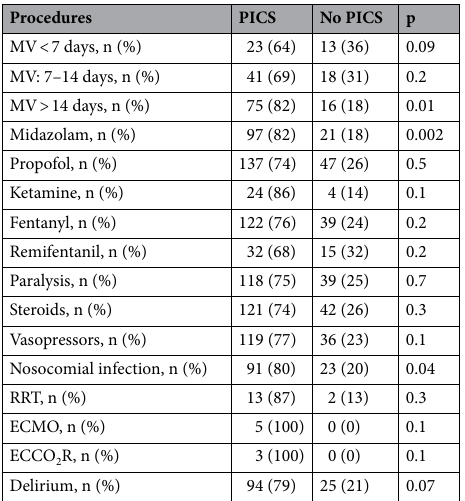
Table 5. Association between complications/procedures during ICU admission and PICS (N = 186). ICU intensive care unit, PICS post-intensive care syndrome, MV mechanical ventilation, RRT renal replacement